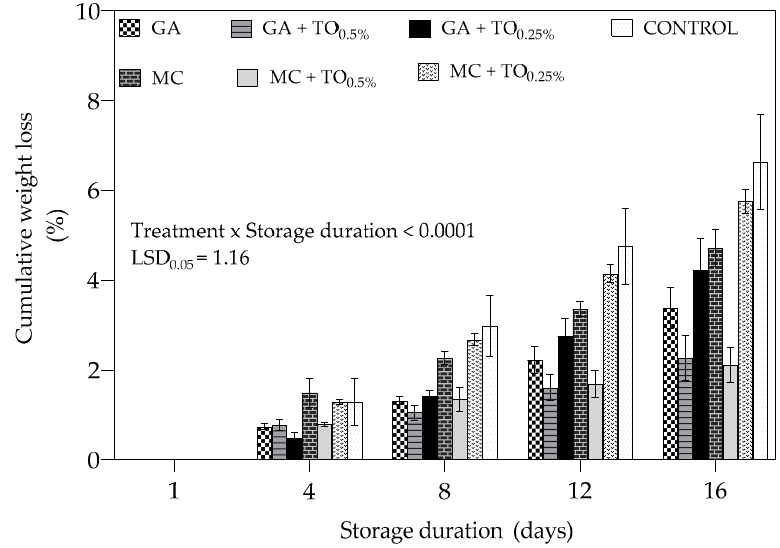
Figure 1. Cumulative weight loss (%) in “Acco” pomegranate arils coated with gum arabic and methyl cellulose coatings enriched with thyme oil (0.5% and 0.25%) and stored at 5 ± 1 °C (95 ± 2% RH) for 16 days. Vertical bars represent the standard error (SE) of mean values of three replicates (1 punnet = 1 replicate). LSD 0.05 represent least significant difference ( p < 0.05).